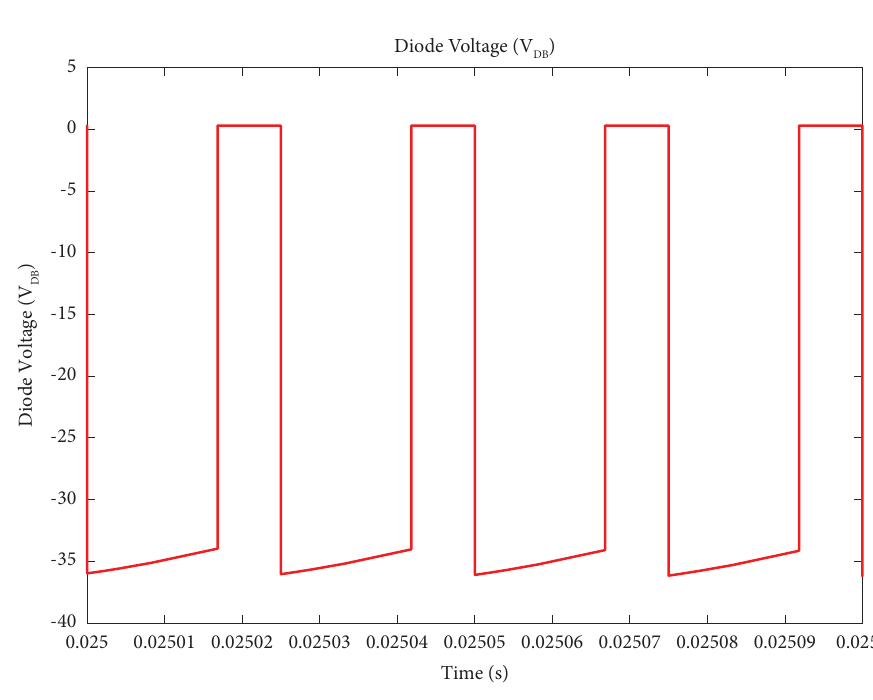
Figure 15: Te diode D B simulated voltage